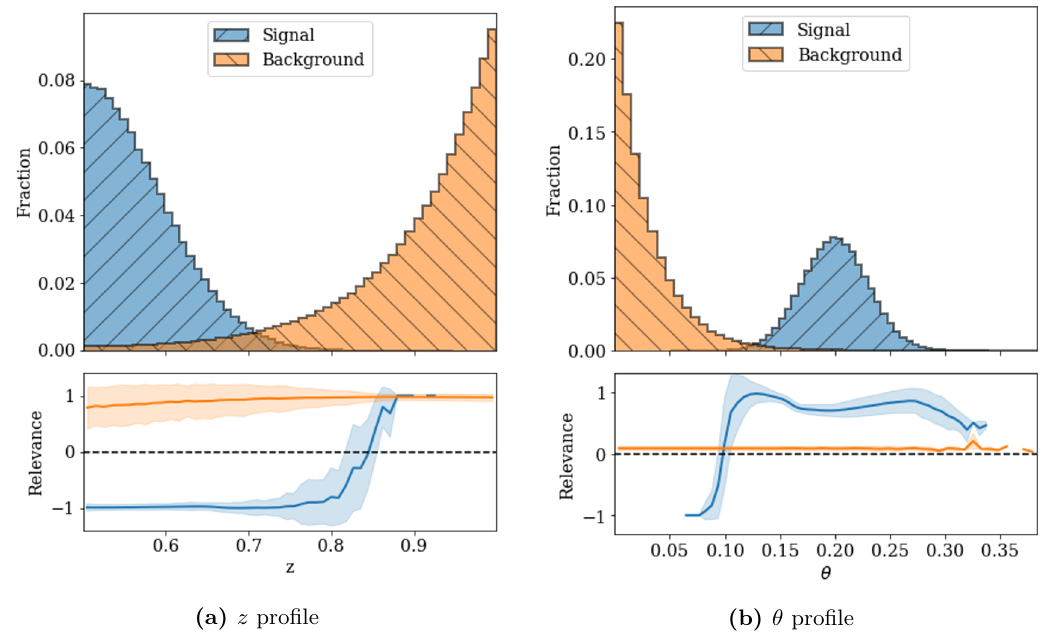
Figure 15. Profiles for Toy 2D CNN Model with relevance and predictions averaged over the four models previously shown.